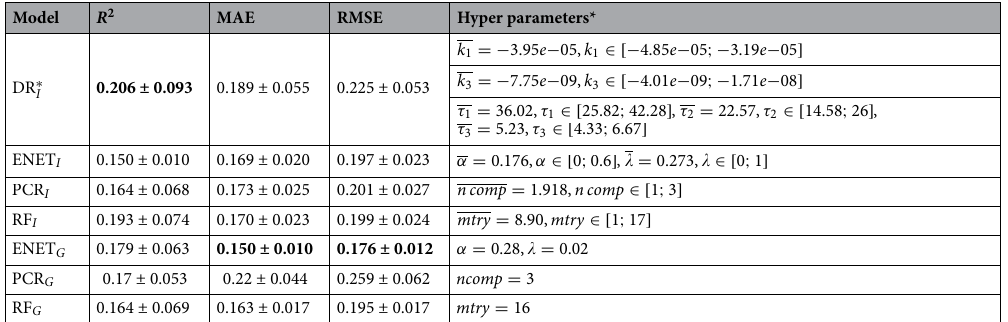
Table 3. Summary of the predictive models. According to model families, criteria were averaged among folders and displayed with their standard deviation. For individual models, averaged values of hyper parameters are displayed along with lower and upper recorded values. The greatest performance among criteria is listed in bold type. *Indicates the DR I as the reference model and specification of its averaged